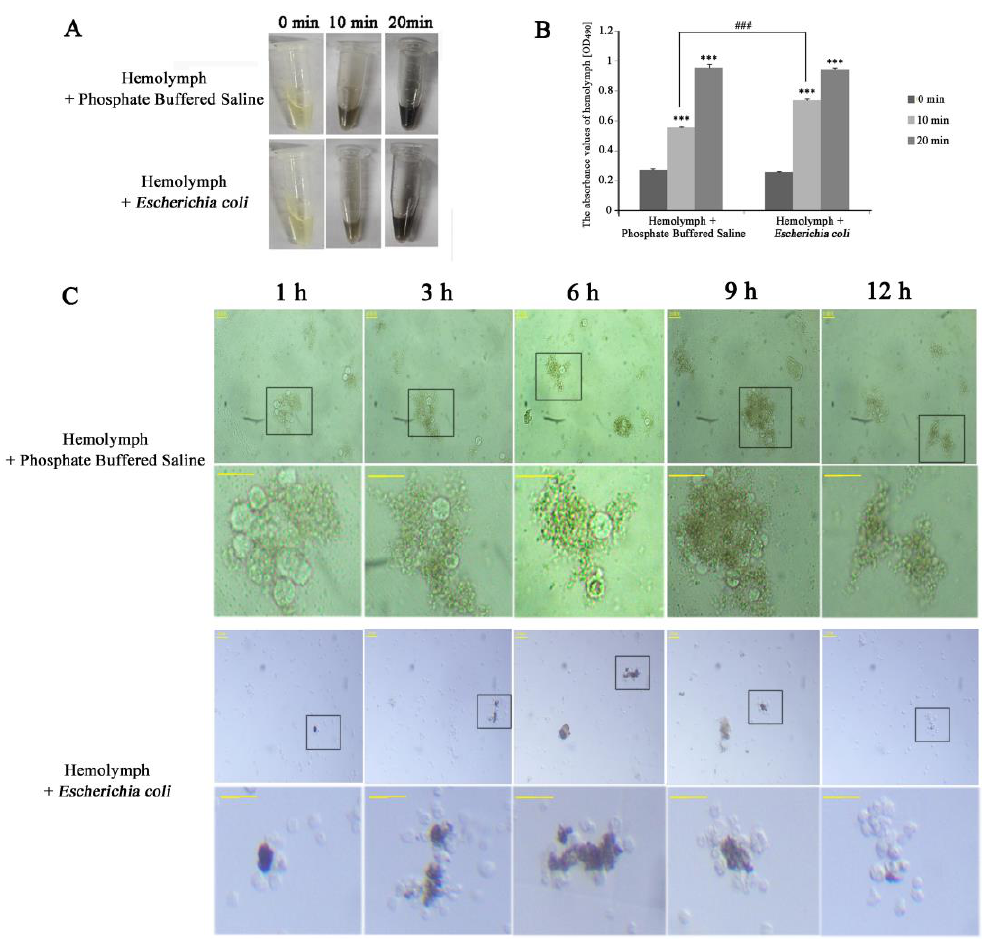
Figure 6. The process of melanization in vitro. ( A ) The profiles of hemolymph colors. ( B ) The profiles of hemolymph colors using a microplate spectrophotometer. Zero, 10 and 20 min represent the incubation times in the air. Statistically significant di ff erences are denoted with * / # ( p < 0.05), ** / ## ( p < 0.01) or *** / ### ( p < 0.001) compared to 0 min for each group and in 10 min between two groups, respectively. ( C ) The profiles of hemocytes morphology. The black boxes show the areas to zoom in on. The bottom-line is a local area magnification of hemocyte morphology corresponding with the top line in both groups. One, 3, 6, 9 and 12 h represent the incubating times of the mixture. The horizontal bar “ 一 ” represents 20 μm.